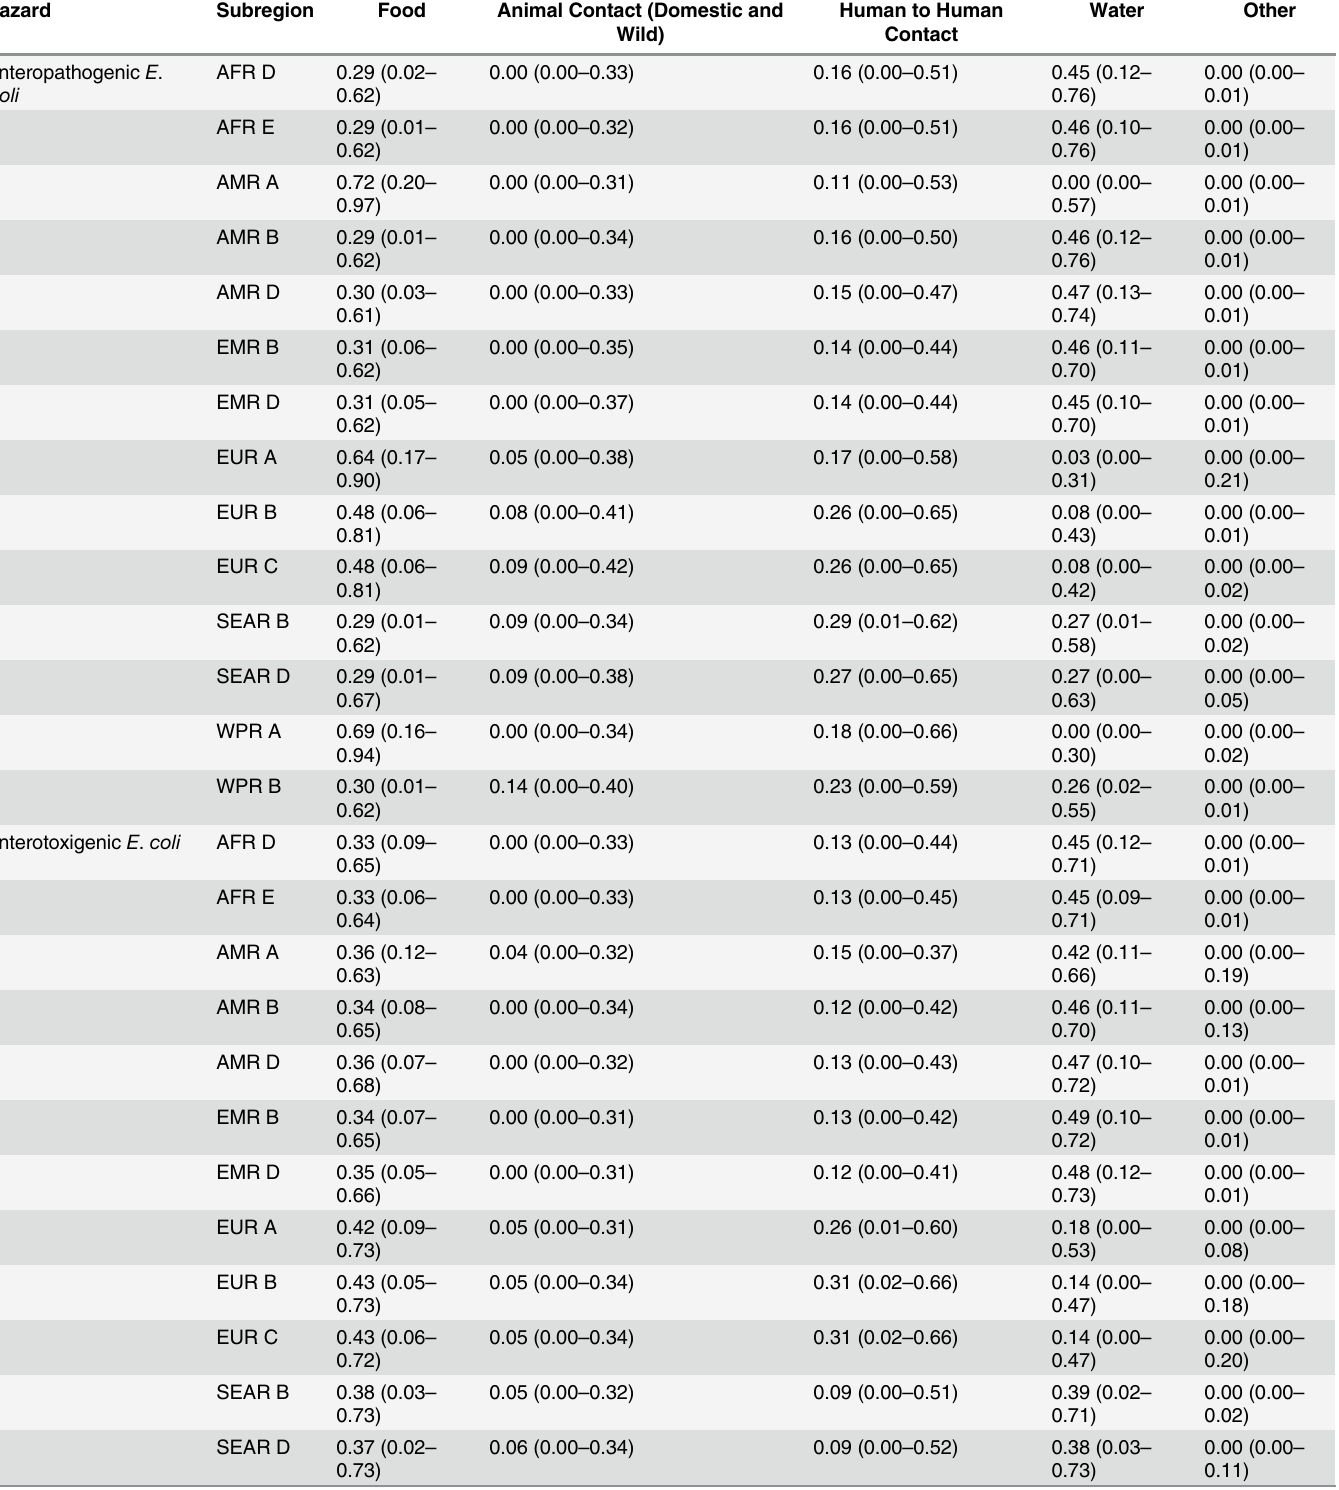
Table 6. Subregional estimates (median and 95% uncertainty interval) of the proportion of illnesses caused by enteropathogenic E . (EPEC), enterotoxigenic E . coli (ETEC), Cryptosporidium spp. and Giardia spp. through each exposure